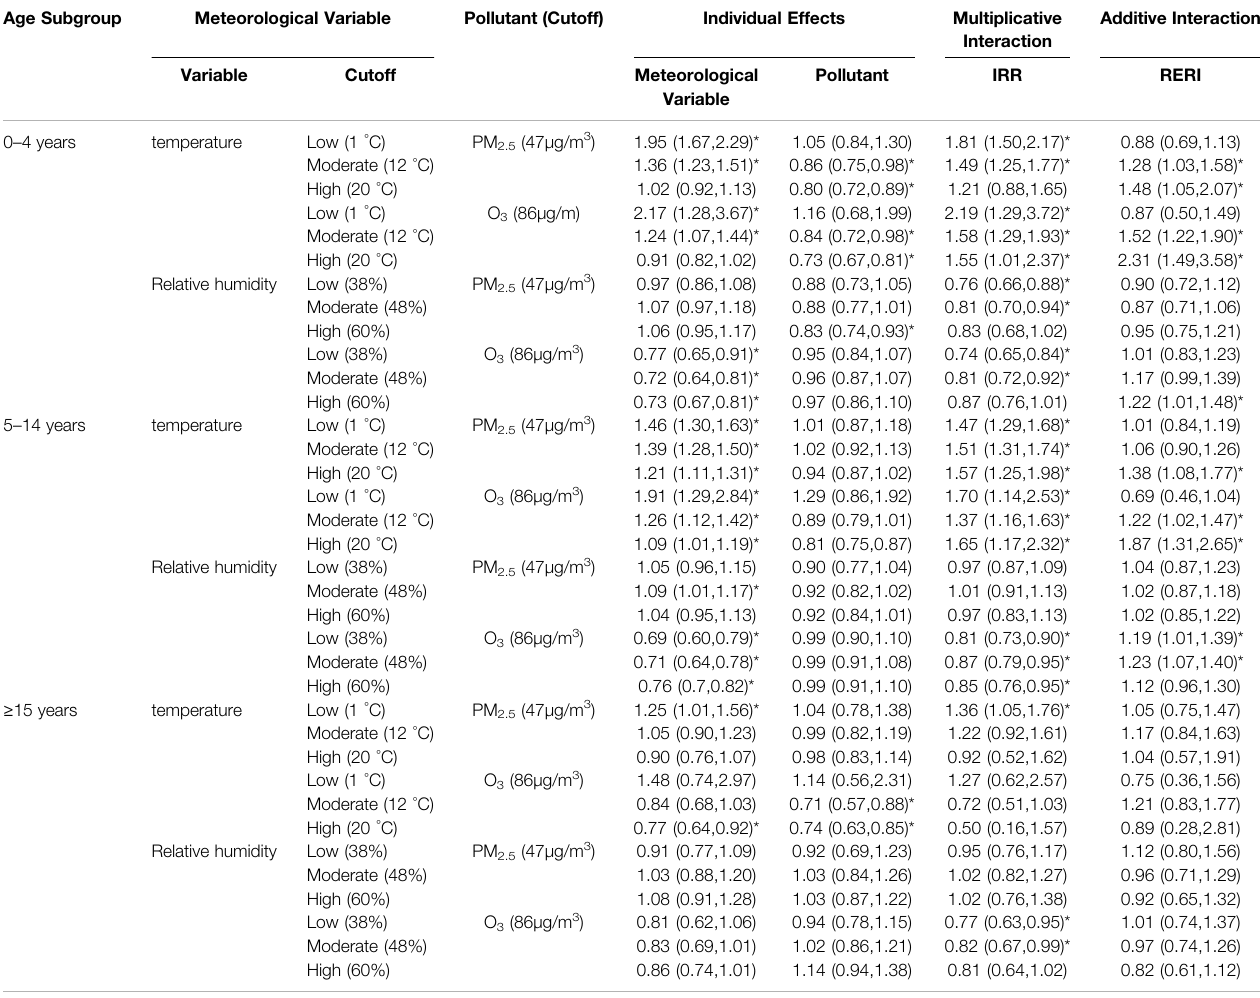
TABLE 4 | Subgroup interactive analysis between meteorological variables and air pollutants on